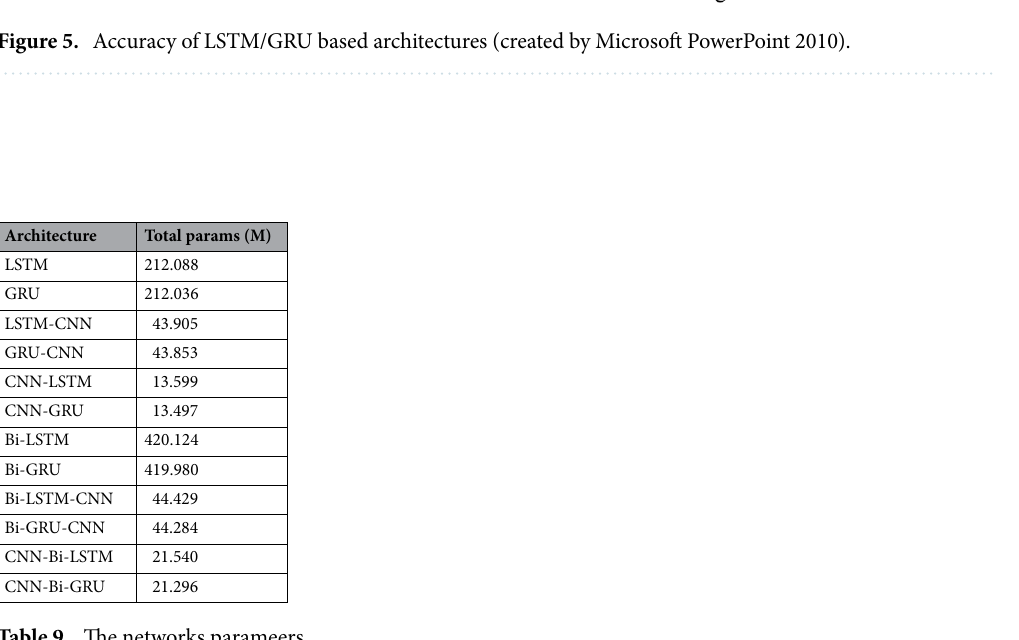
Table 9. The networks